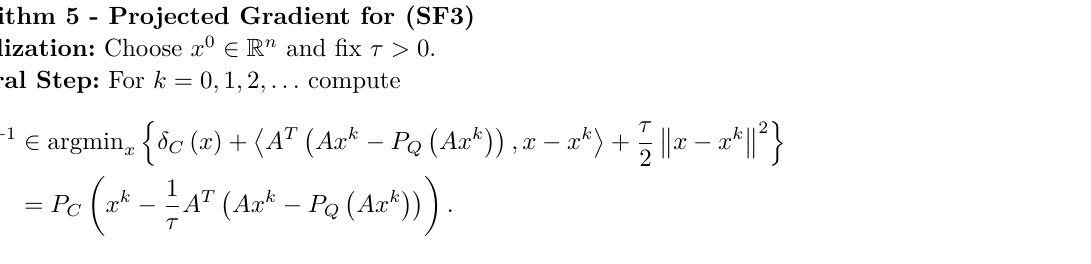
Algorithm 5 - Projected Gradient for